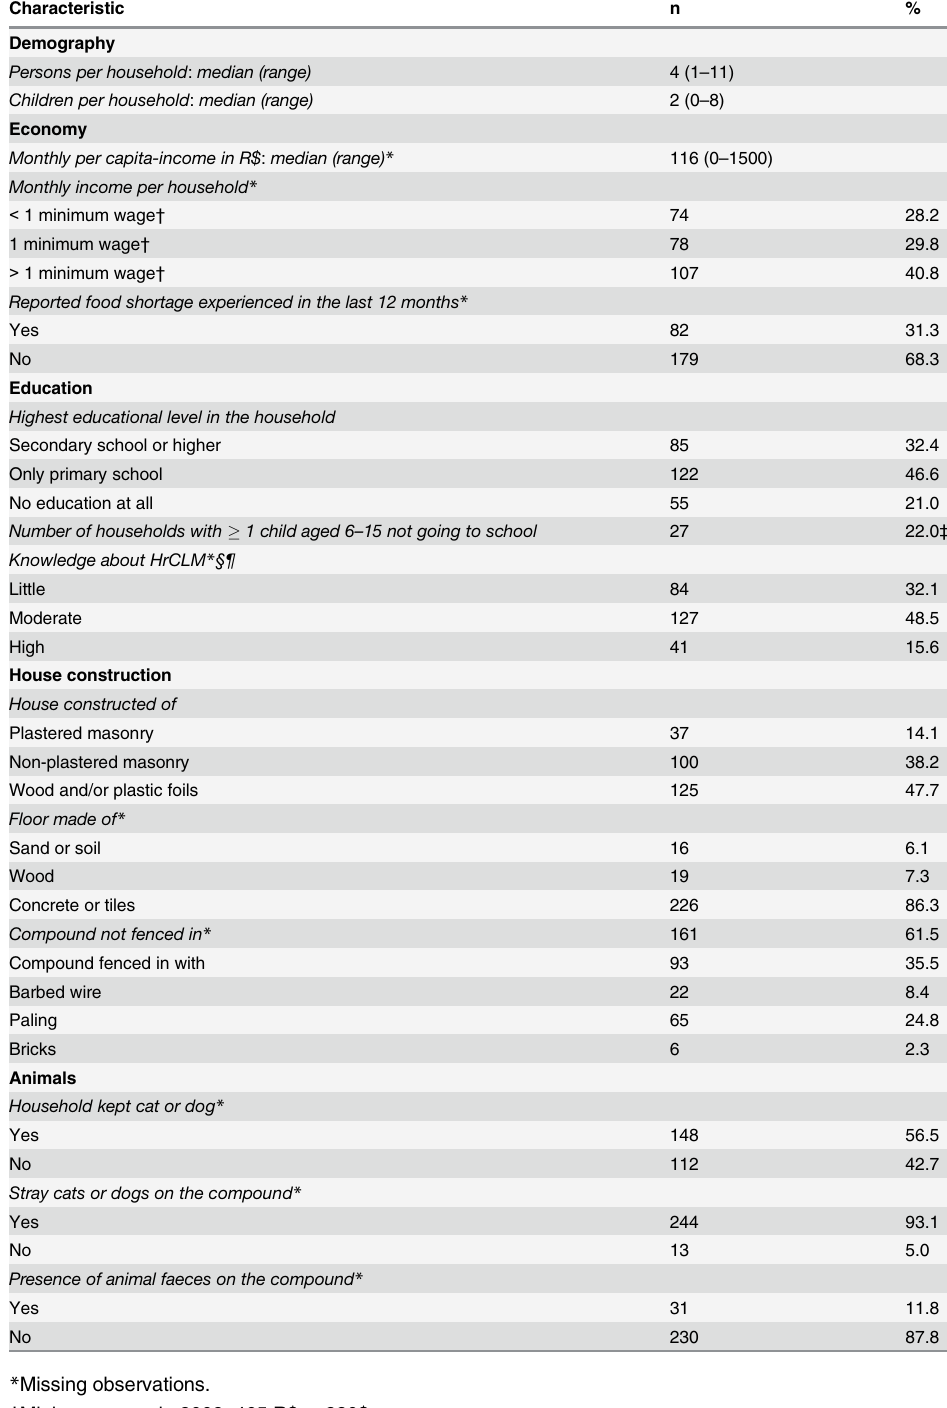
Table 1. Demographic, socio-economic and environmental characteristics of study households (N =